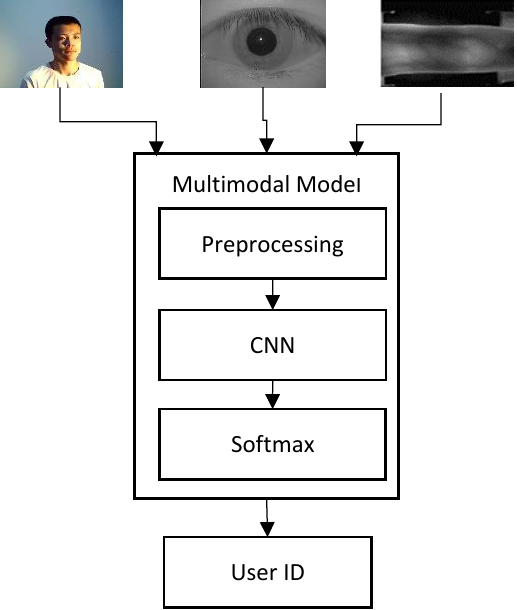
Figure 1. The general structure of the proposed system.